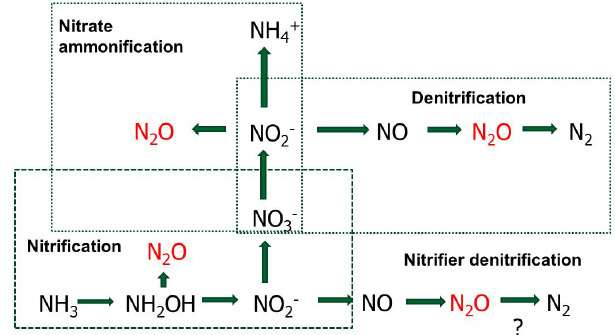
Figure 7. A schematic diagram of the microbial processes con- tributing to N 2 O production (adapted from Baggs,